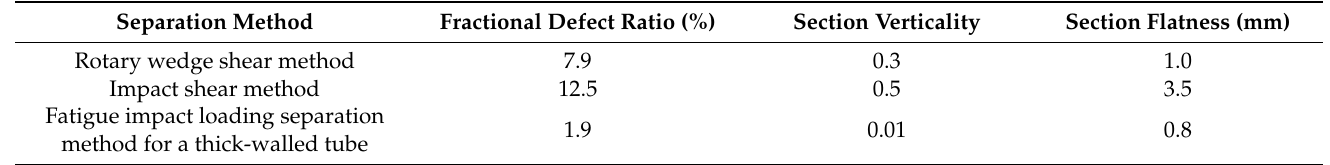
Figure 12. Comparison of tube sections obtained by different separation methods: ( a ) Rotary wedge shear method; ( b ) Impact shear method; ( c ) Fatigue impact loading separation method for a thick- walled tube.